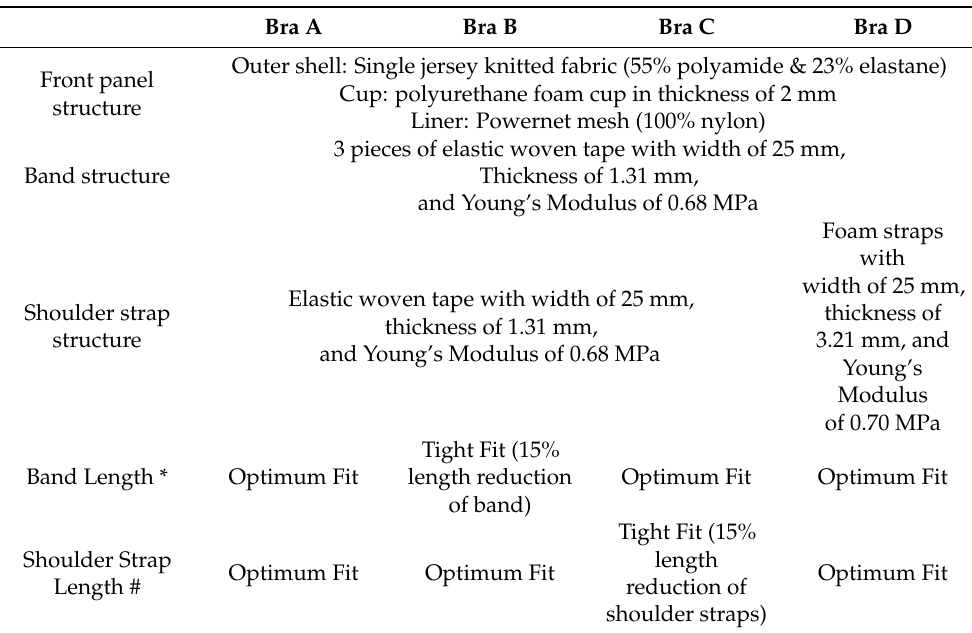
Table 1. Fabrication details and fit adjustments of the 4 bra conditions.